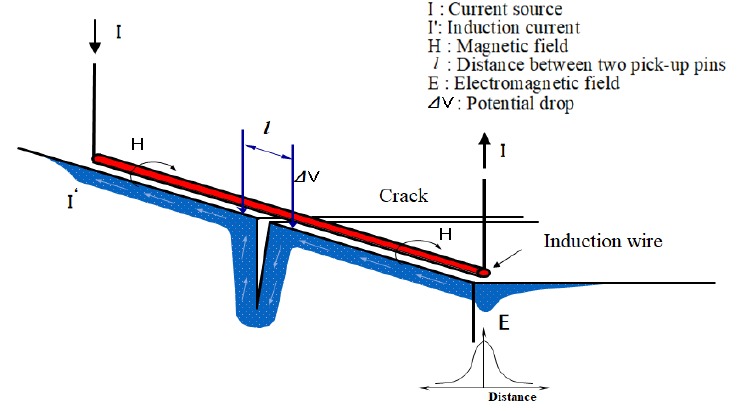
Figure 1. Principal of induced alternating current potential drop (IACPD).